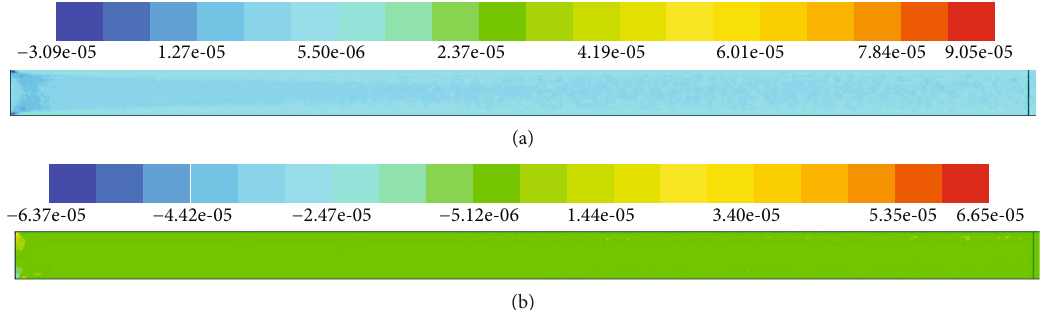
≤ 40 mm in the discrete-phase model: (a) X 1